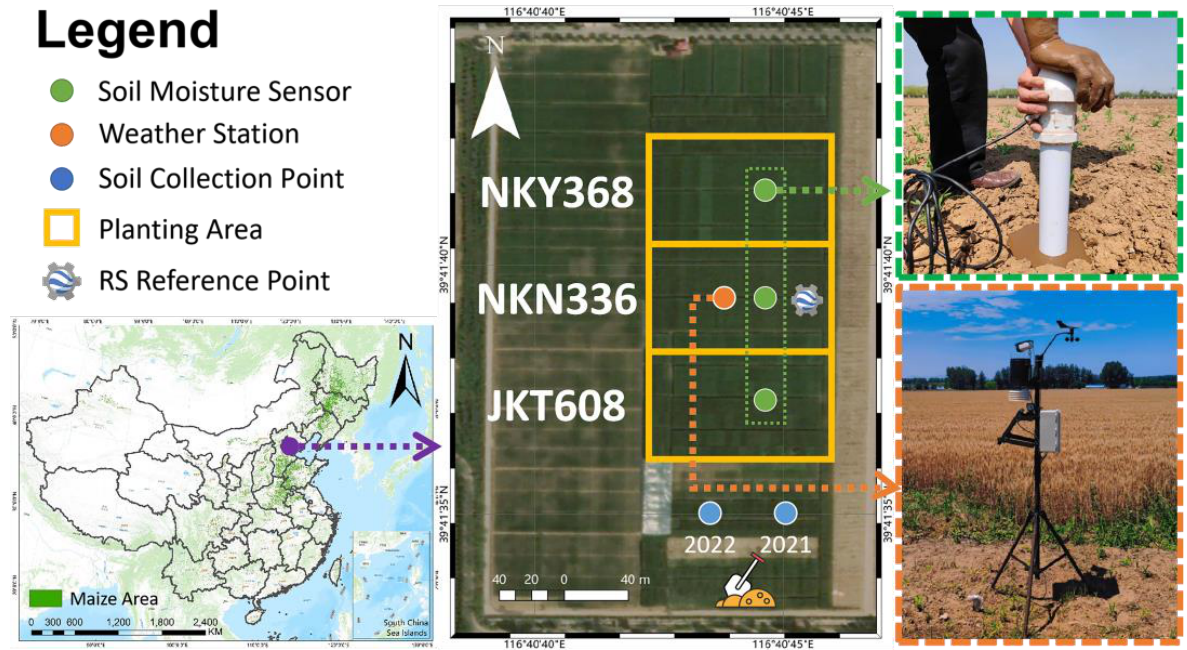
Figure 4. Overview map of experiment area and sensor deployments.